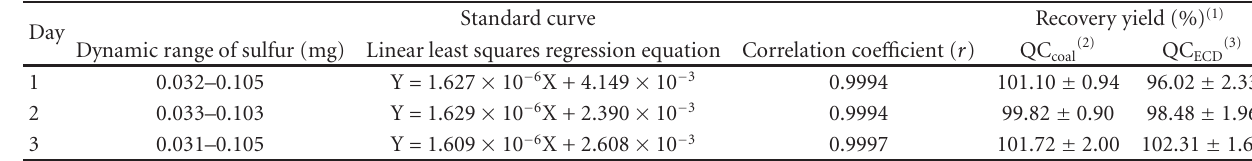
Table 4: Stability study of QC samples analysis.